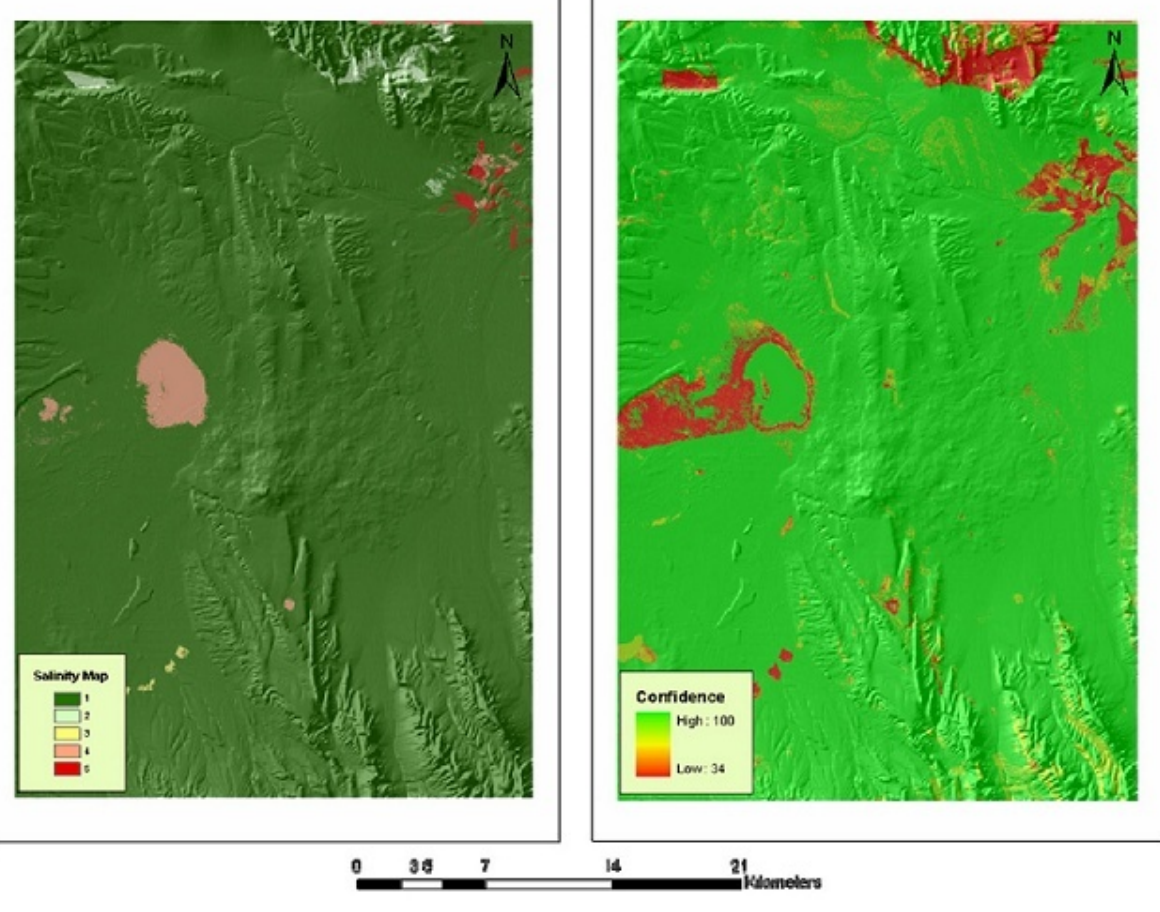
Figure 4 . Predicted soil salinity map using decision tree analysis (left) and its prediction